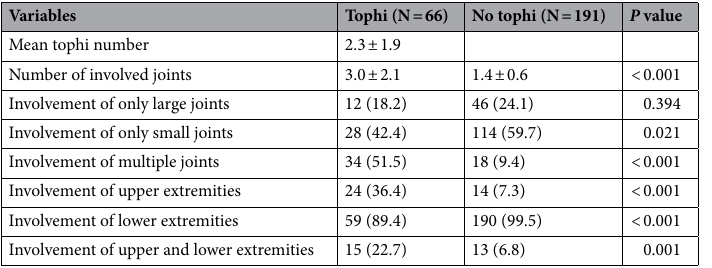
Table 2. Involved joints in patients with gout at baseline. Results are expressed as the mean ± SD, or as number (%).